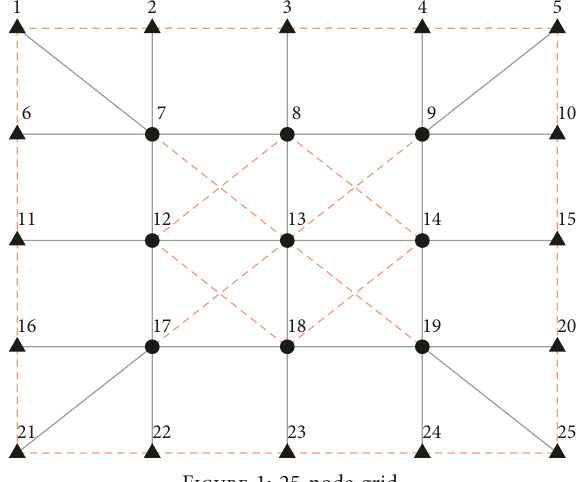
Figure 1: 25-node